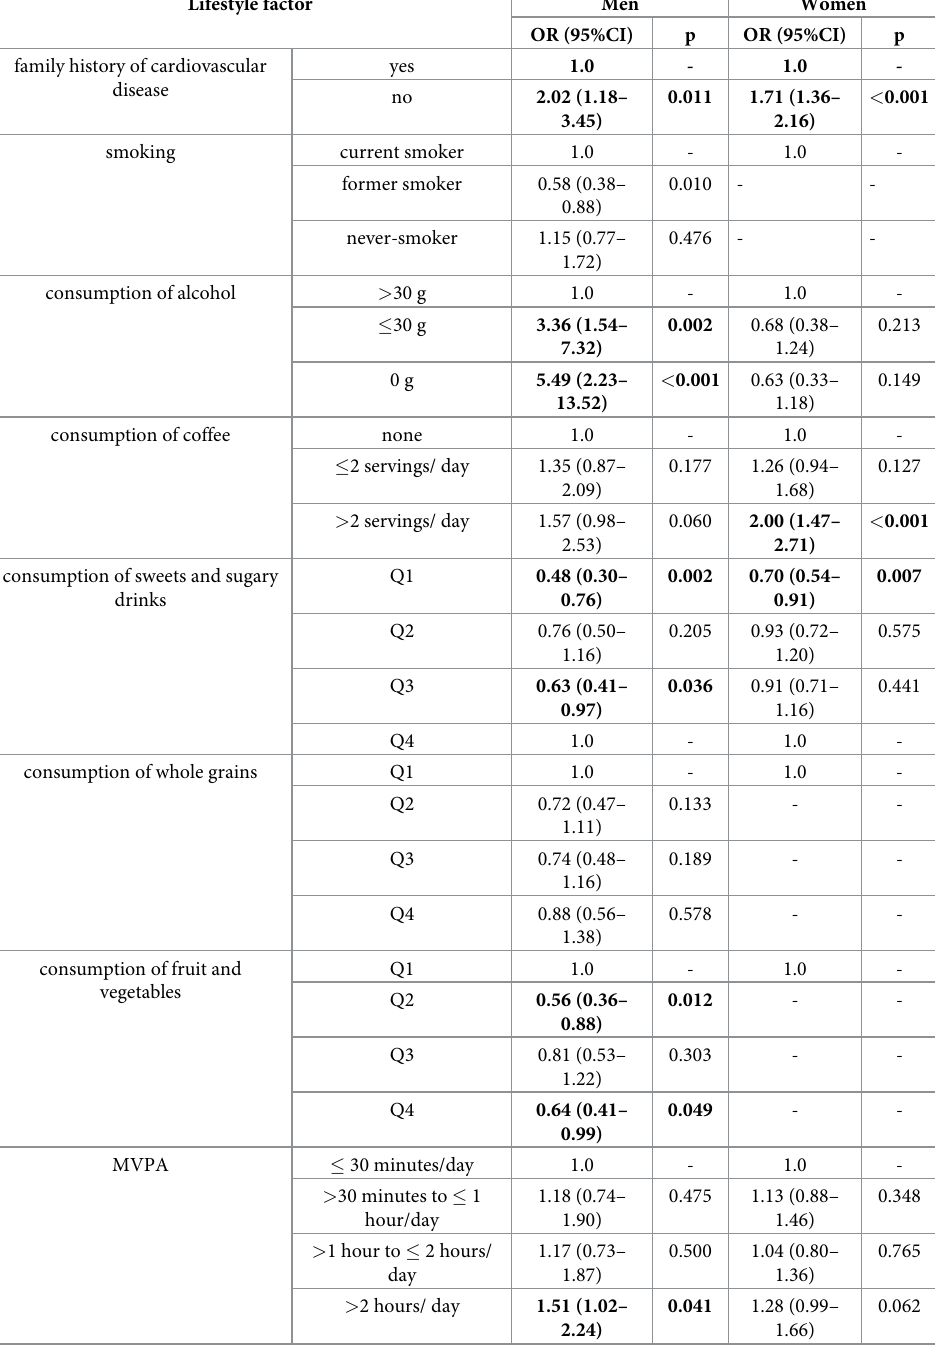
Table 3. Factors associated with metabolic health. Multivariate analyses with backward stepwise selection results for � 3 components of MetS in men and